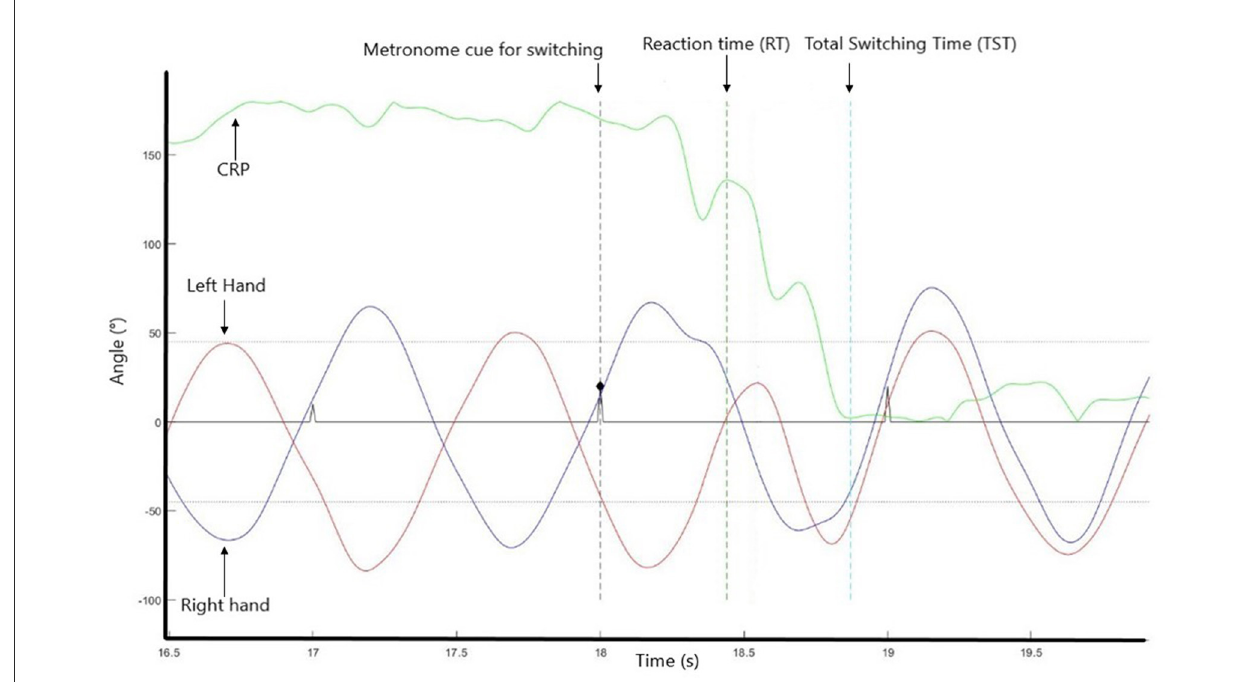
FIGURE2 Decomposition of the switching phase into different sub-parts.